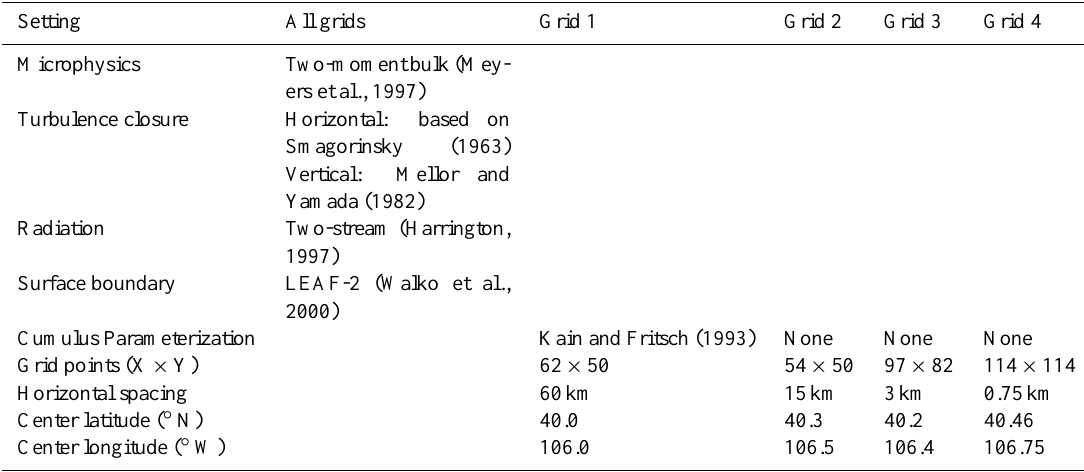
Table 2. Settings used for all RAMS sensitivity